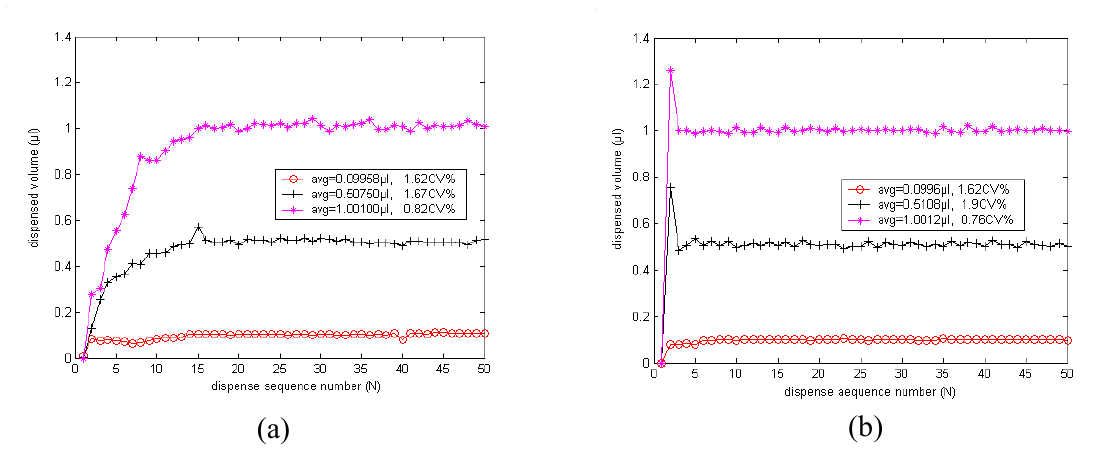
Figure 12. (a) The dispensed volume in each cycle with only fuzzy control strategy, (b) The dispensed volume in each cycle with intelligent compound control